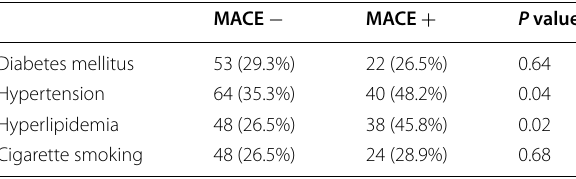
MACE major adverse cardiovascular events